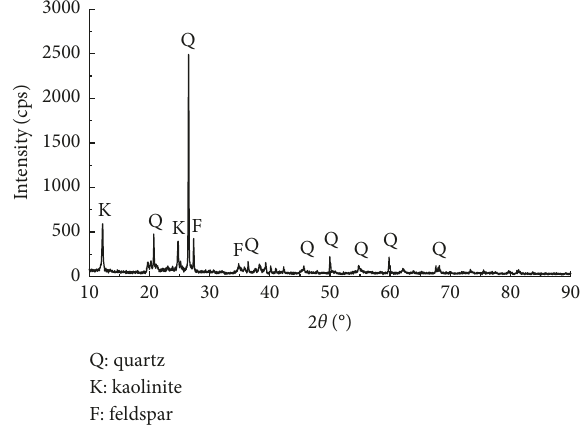
Figure 1: XRD spectrum of tested